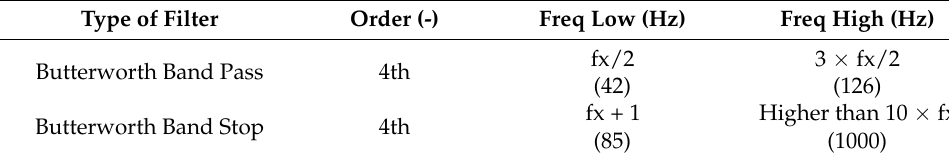
Table 1. Basic types of active filters and their configuration settings.